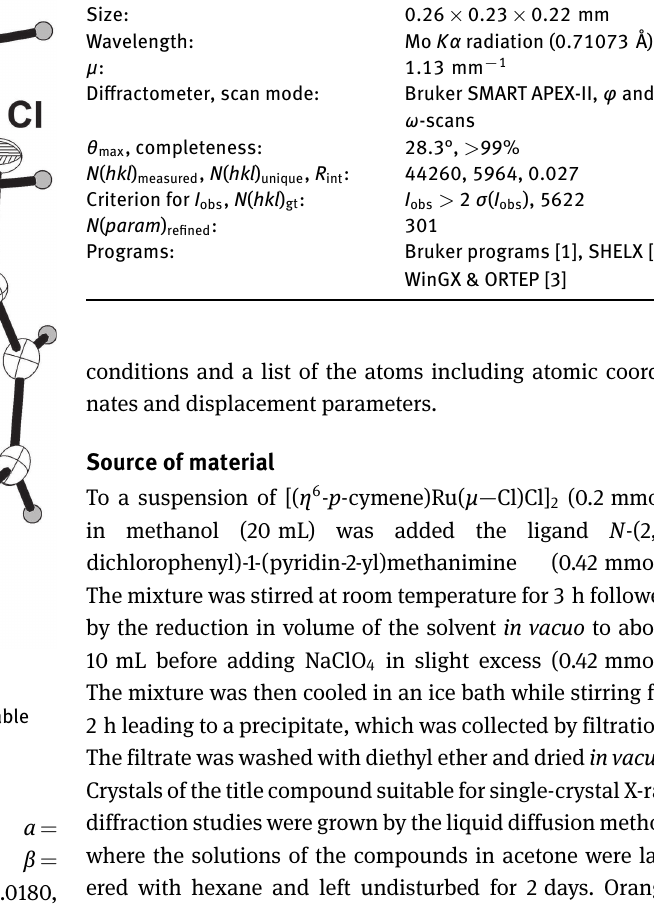
The title crystal structure is shown in the figure. Tables 1 and 2 contain details on crystal structure and measurement